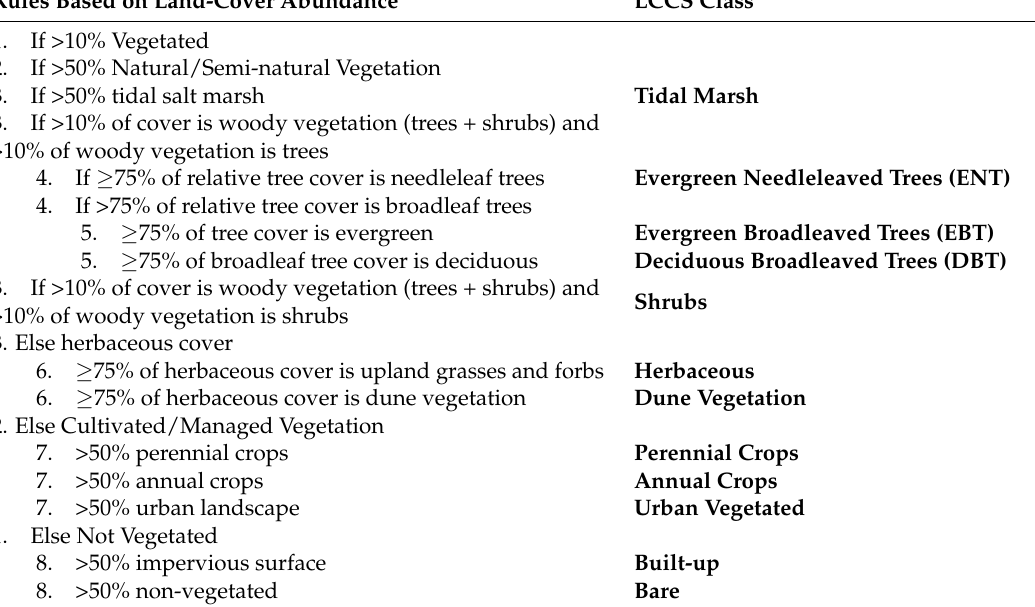
Table A1. The Land-Cover Classification System (LCCS) rules applied to percent cover estimates of land cover in reference samples in order to create discrete class labels. Open-canopy (open) trees and shrubs have >10–65% trees or shrubs, respectively. Closed-canopy (closed) trees and shrubs have >65% trees or shrubs, respectively. This study focused on closed-canopy tree and shrub classes